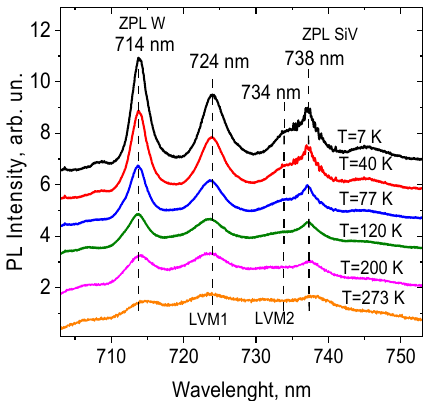
Figure 2. A representative set of PL spectra of single HFCVD diamond nanocrystal in the range of emission of W complex at different temperatures from 7 K to 273 K. Positions of the ZPL (714 nm) and several LVM replicas (724 nm, 734 nm, 745 nm, etc.) of tungsten complexes are shown. The ZPL of SiV − centers at 738 nm can be observed in the low energy area of the tungsten’s second LVM